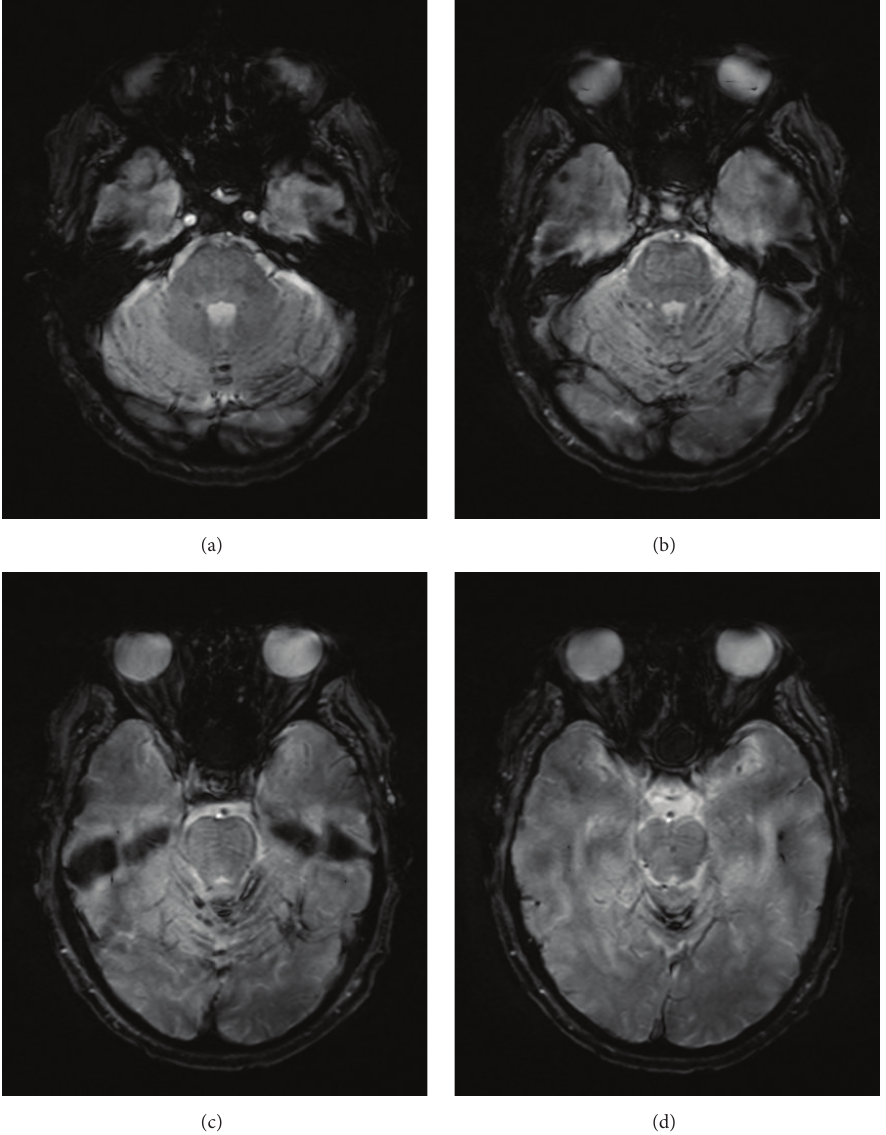
Figure 2: T2-weighted gradient ECHO MRI of the brain: superficial siderosis with hemosiderin deposition seen in the vermis and folia of the